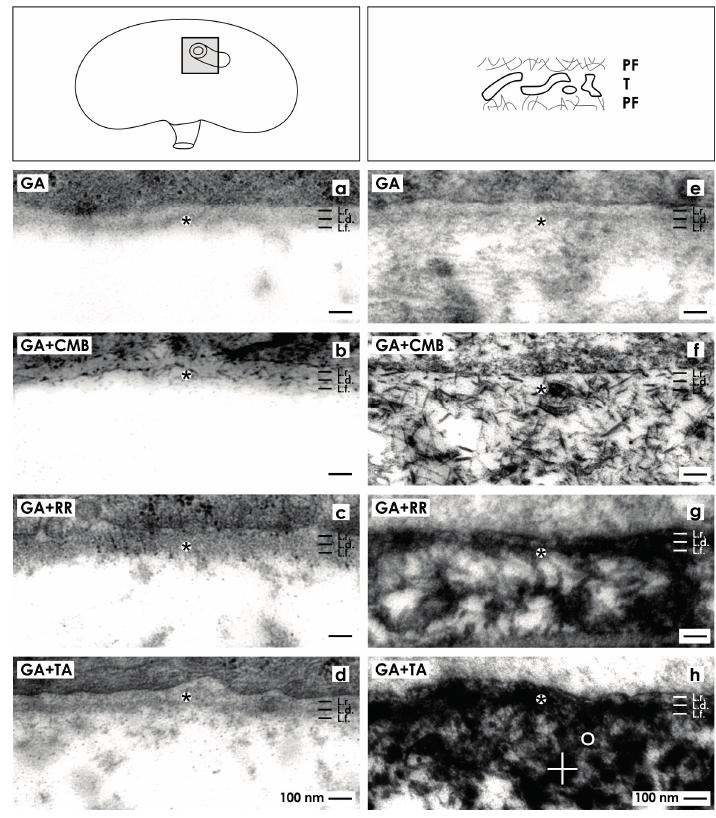
Figure 6. Electron microscopy in matured kidney ( a – d ) and generated tubules ( e – h ). In the kidney an unobtrusive interstitium (asterisk) is seen after fixation in GA solution ( a ); GA solution containing cupromeronic blue ( b ), ruthenium red ( c ) or tannic acid ( d ). Generated tubules exhibit after fixation in GA solution ( e ) an inconspicuous interstitium, while GA solution including cupromeronic blue ( f ), ruthenium red ( g ) or tannic acid ( h ) unveils extracellular matrix. Label by tannic acid shows fibers linked via massive (white cross; diameter 150 nm) or small (round white label; diameter 36 nm)